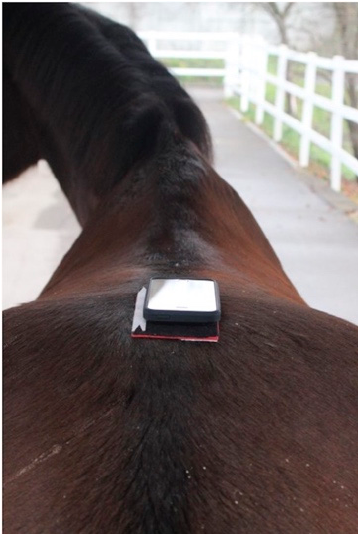
Figure 1. Image demonstrating the placement of the smartphone during data collection.